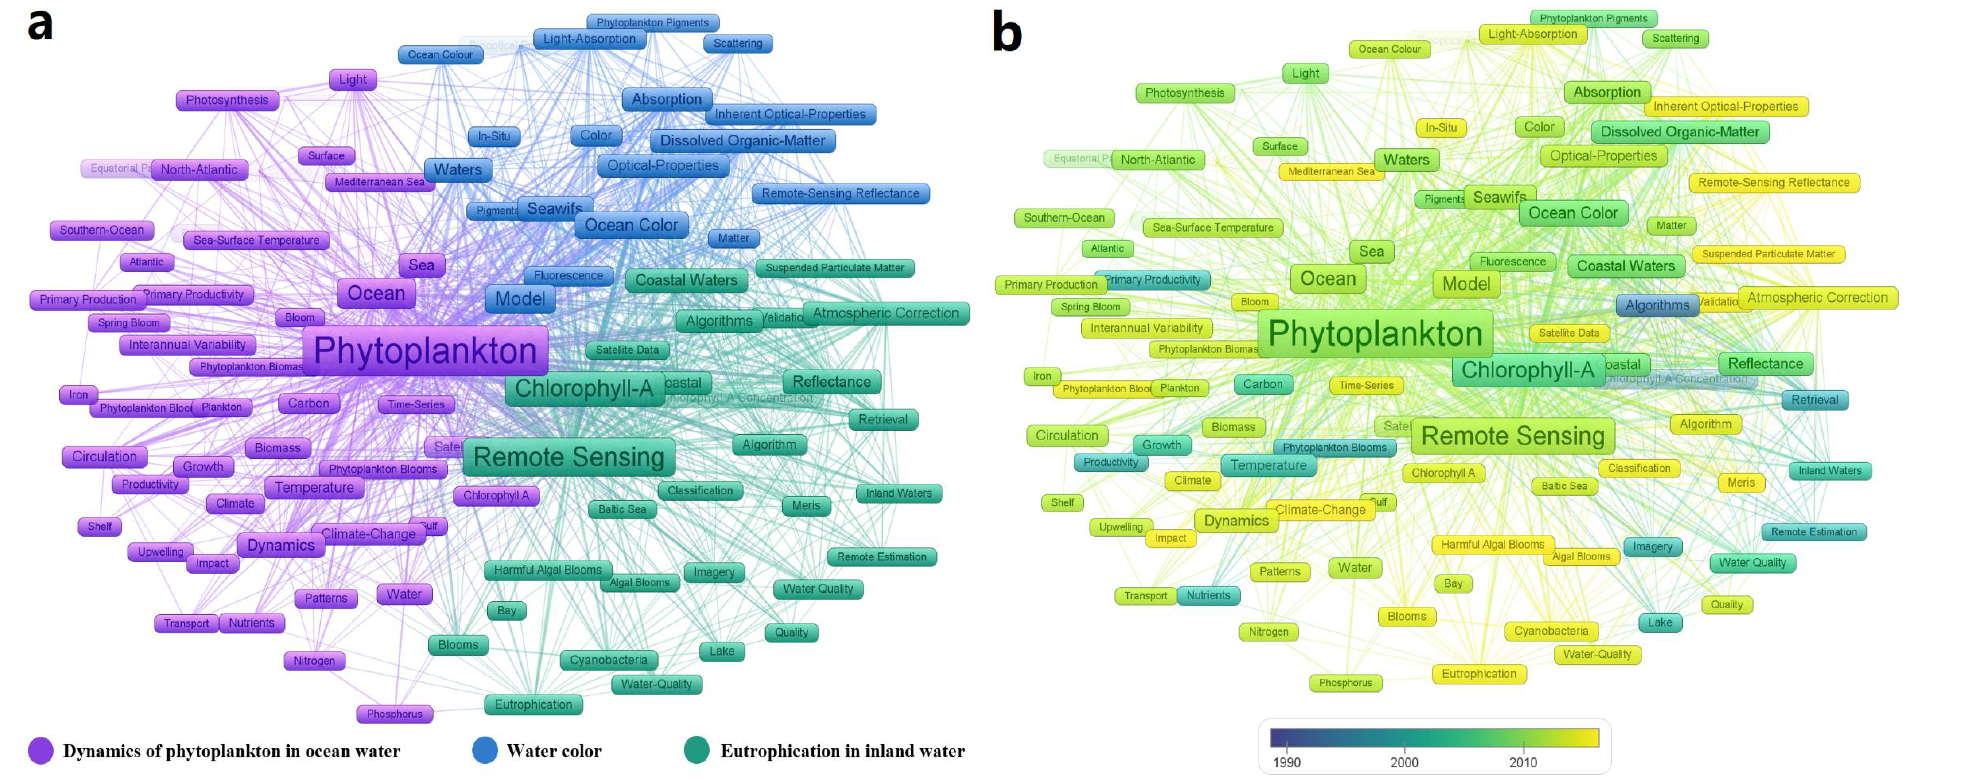
Figure 6. ( a ) Keyword relevance analysis (the larger the box in the graph, the higher the word frequency; the closer the box is to the center, the higher the importance; the thicker the line between boxes, the more times they appeared together). ( b ) Time sequence analysis of keywords (the closer to purple the keyword color is, the earlier the keyword appeared; in contrast, the closer to yellow the keyword color is, the later the keyword appeared).